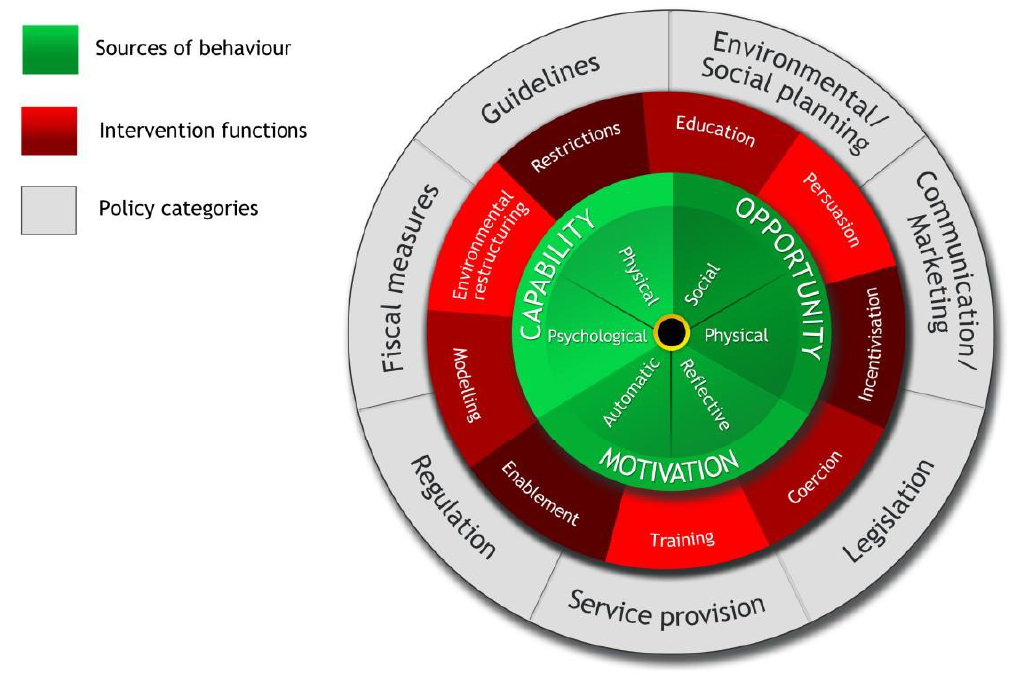
Figure 1. BCW/COM-B Model and their components. Figure by Michie et al. [37]. Utilized under Creative Commons Attribution License.